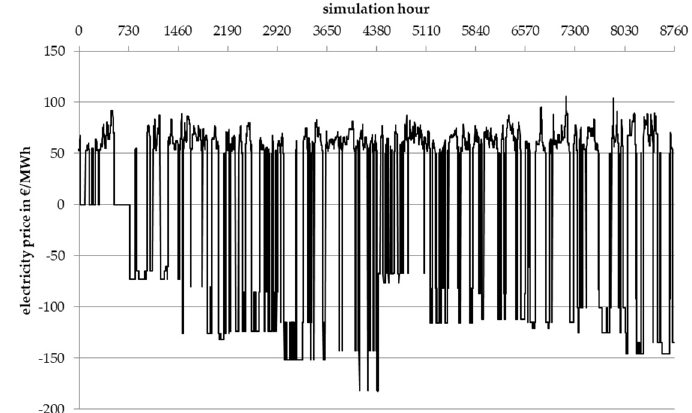
Figure A2. Market prices for one year in the extended wind scenario.